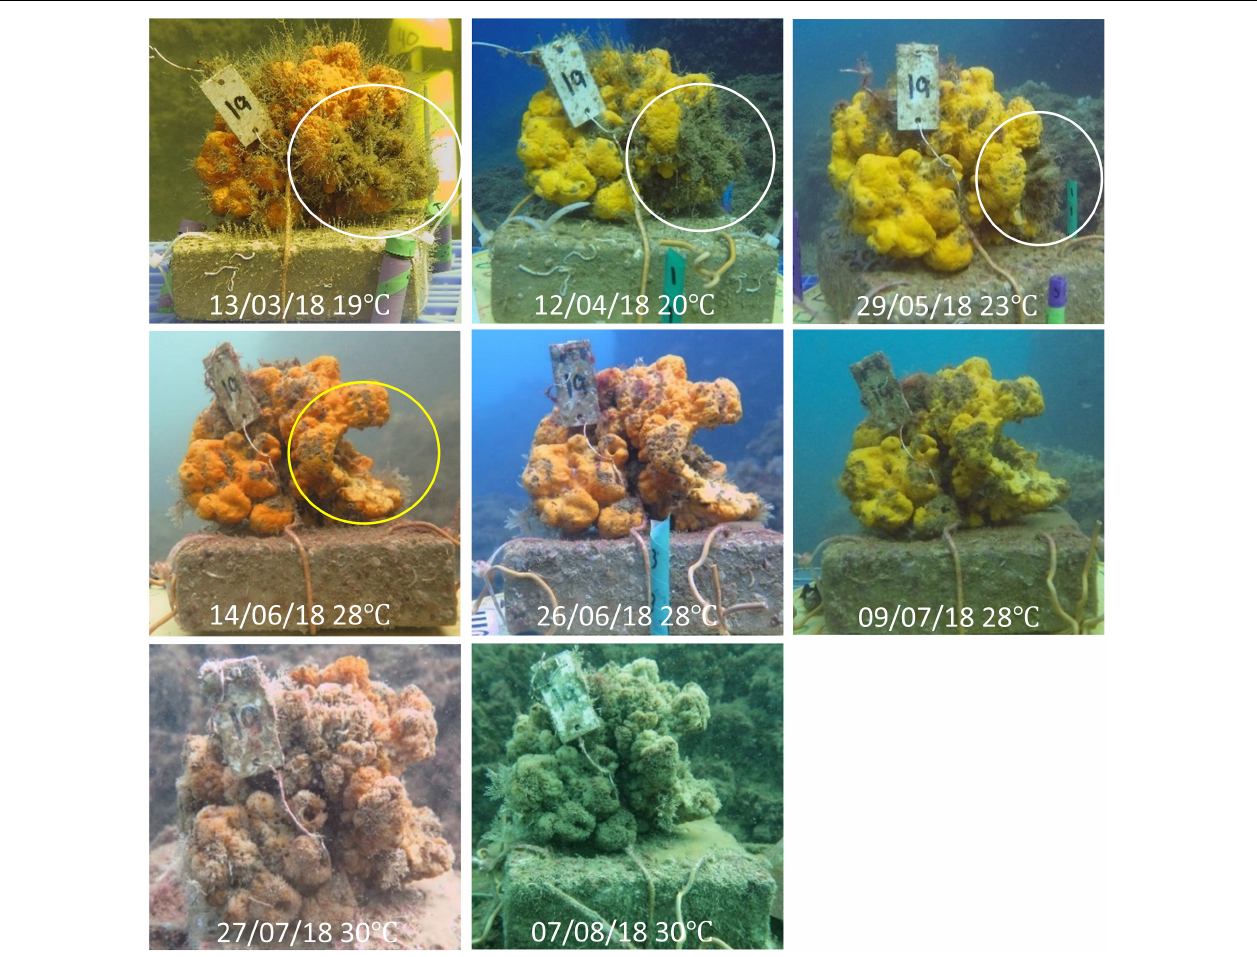
FIGURE 3 | Sponge #19 throughout the experiment: dates and seawater temperatures are noted on each image. The part of the sponge damaged by the ROV during collection became necrotic (circled) on 13/03 – 29/05. Later (14/06), the necrotic part detached, and a new ectosome is visible. On 09/07, the sponge stopped pumping seawater. By 27/07, the sponge was dead, and on the 07/08, only the skeleton